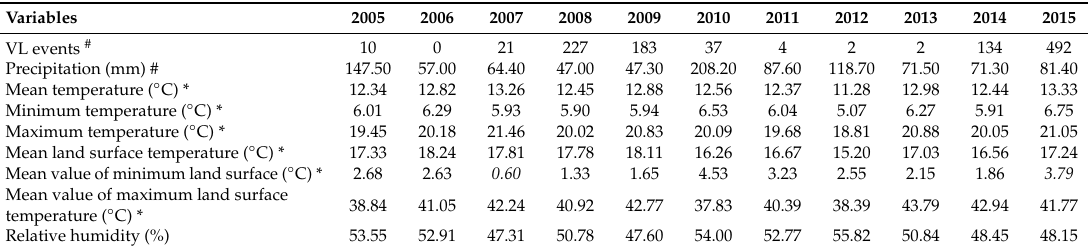
Table 5. Yearly values of VL events and meteorological factors.